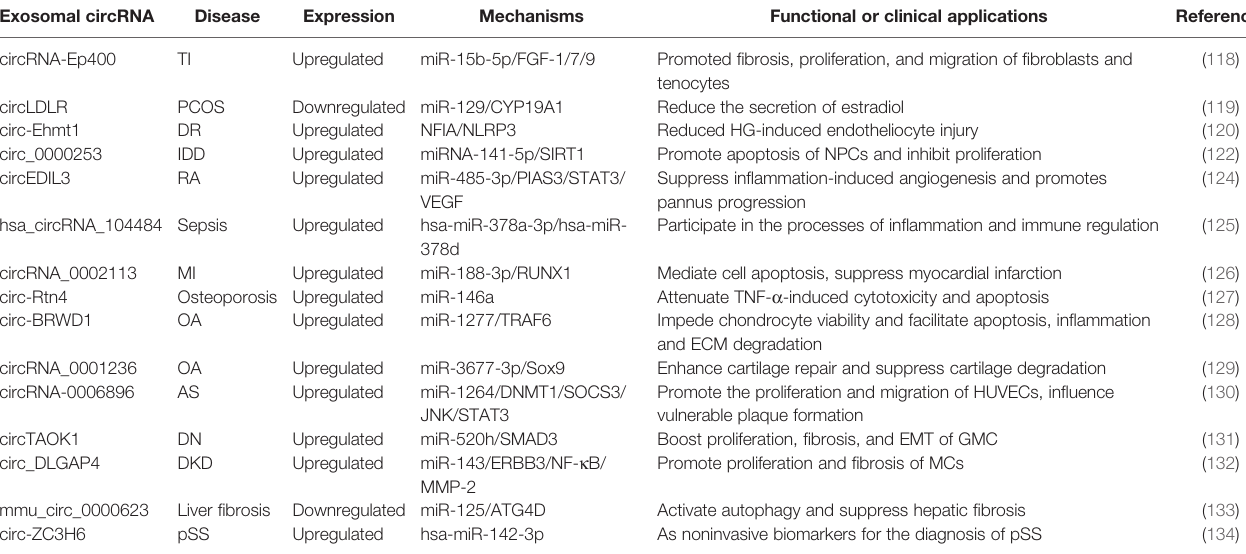
TABLE 2 | Function and clinical signi fi cance of exosomal circRNAs in other diseases. Exosomal circRNA